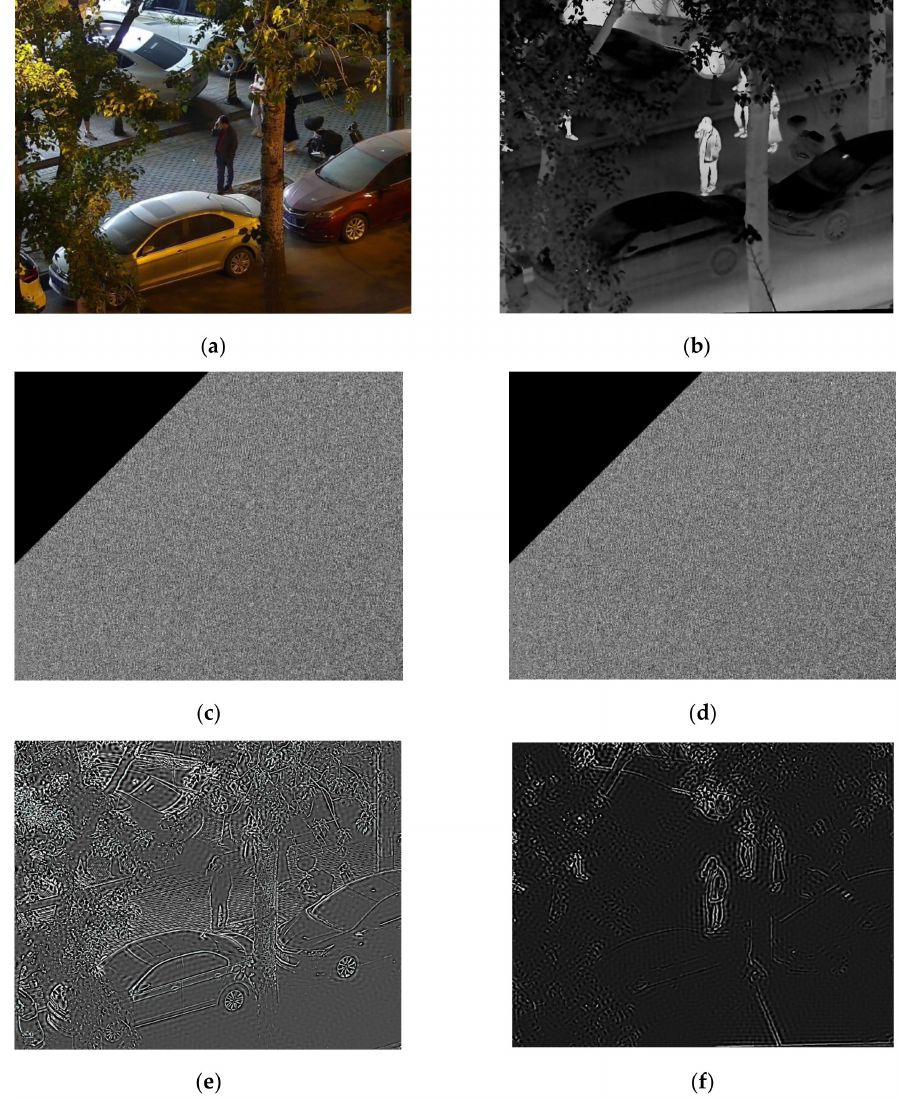
Figure 5. ( a ) RGB image; ( b ) IR image; ( c ) HF extraction in the DCT domain (RGB image); ( d ) HF extraction in the DCT domain (IR image); ( e ) extracted HF result (RGB image). ( f ) extracted HF result (IR